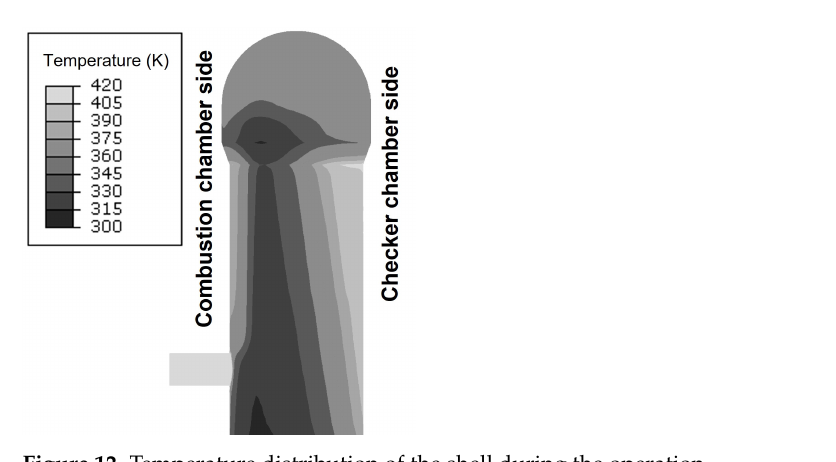
Figure 12. Temperature distribution of the shell during the operation.